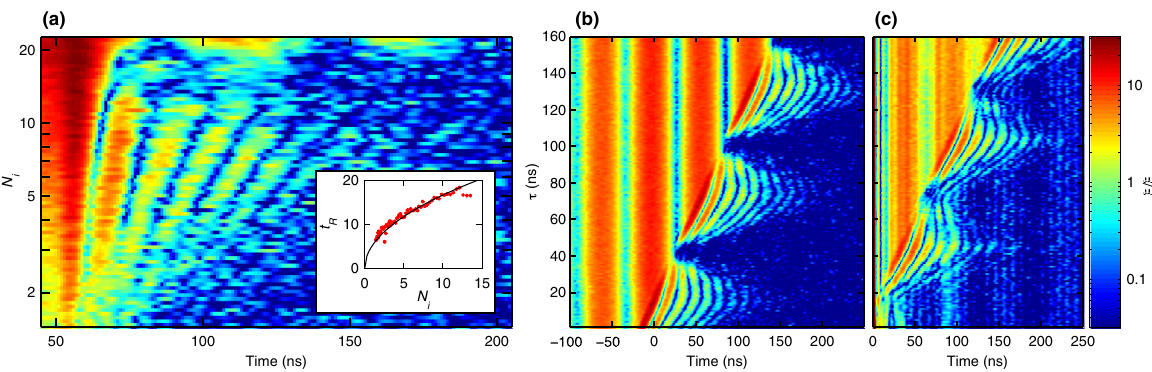
FIG. 5. Self-trapped regime. (a) Homodyne signal dynamics of the right cavity as a function of initial photon number and time. A 345- ns ( 3 =J ) initialization pulse V ending at t ¼ 0 generates linear oscillations between the left and right cavities while photon-photon drive interactions are off. The oscillations proceed for a time τ such that a perfect imbalance ( Z ¼ − 1 ) is established when interactions are < N turned on. For N , the system is localized and the right cavity displays fast collapse and revival oscillations while the left cavity ffiffiffiffi p i c N (not shown) remains empty. Inset: Fitting revival time t as a function of drive power to the expected dependence allows drive power r to be mapped to initial photon number (at t ¼ 0 ), as well as the calibration of ξ 1 , the homodyne signal of a coherent state with mean occupation of one photon. (b),(c) Revival time variation as a function of τ for V applied to the left (left-hand panel) and right (right- drive ¼ 8 , hand panel). As τ is varied, the full range of imbalance is observed. Here, the same initialization scheme as in (a) is used with N i which produces the cleanest collapse and revival signature. When driving the right cavity, strong reflections during V give rise to drive signal distortion during the dynamics (visible in the right-hand panel) that are mitigated by using a microwave